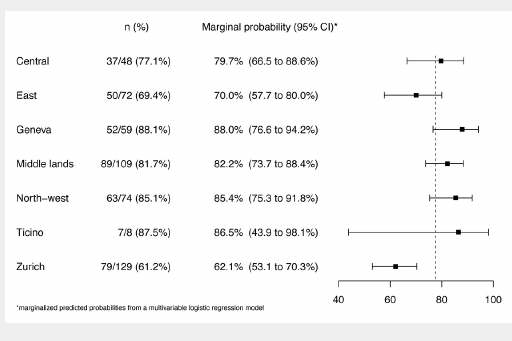
Probability of reporting testing of all women for human immunodeficiency virus (HIV), hepatitis B virus (HBV) and syphilis, by region adjusted for place of work, year of specialist certification, and gender. The dashed line indicates the overall mean, boxes are the point estimate, bars are 95% confidence intervals